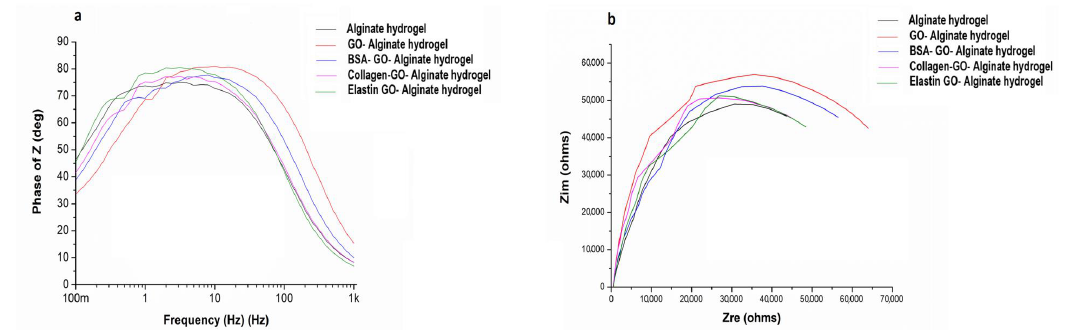
Figure 7. Electrochemical study from protein coated-GO alginate hydrogels compared to alginate hydrogels. ( a ) Bode plots, (phase angle Z vs. frequency from 10 − 1 to 10 3 Hz. ( b ) Nyquist diagram, Zim vs. Zre (ohm).